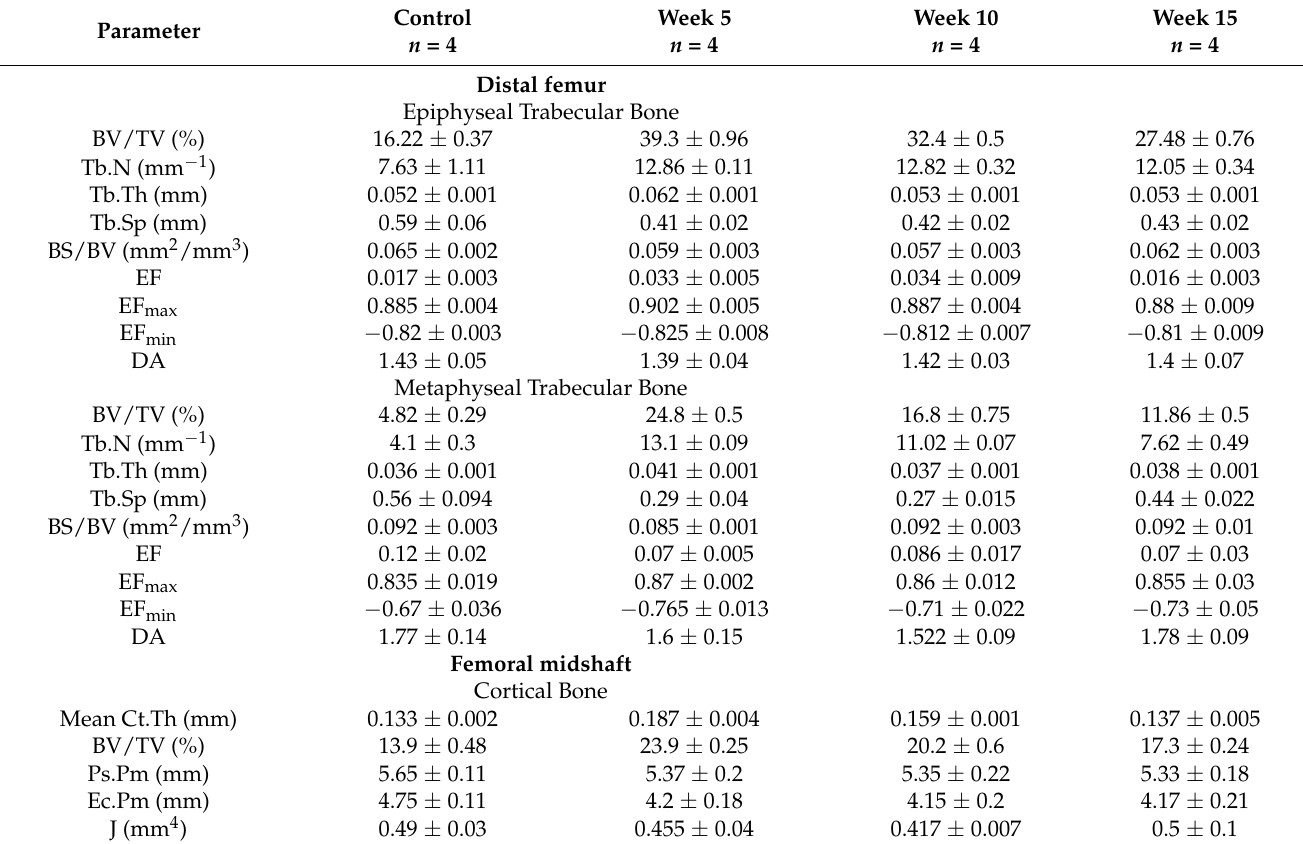
Table 1. Detailed bone structural